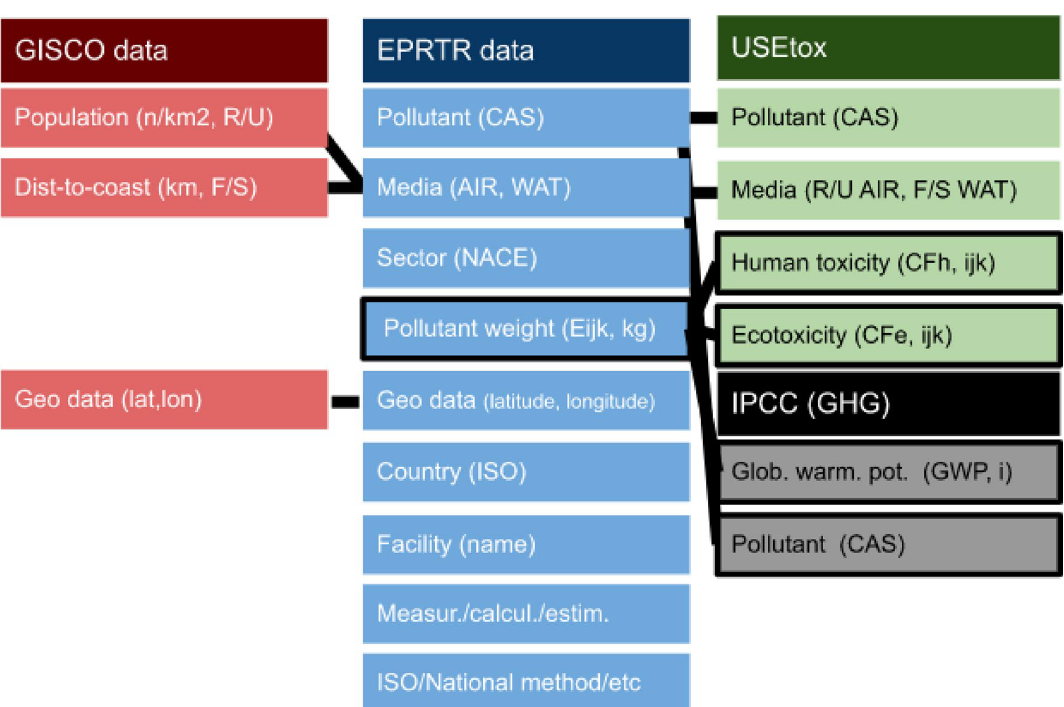
Figure 5. Illustration of connection of the E-PRTR with USEtox model and IPCC GHG global warming potential values. Notes CAS—Chemical Abstracts Service registry number, lat—latitude, lon—longitude, F/S— freshwater/seawater, R/U—rural/urban, CF ijk —characterization factor for the potential toxicity impacts of the substances released by facility i to media j and submedia